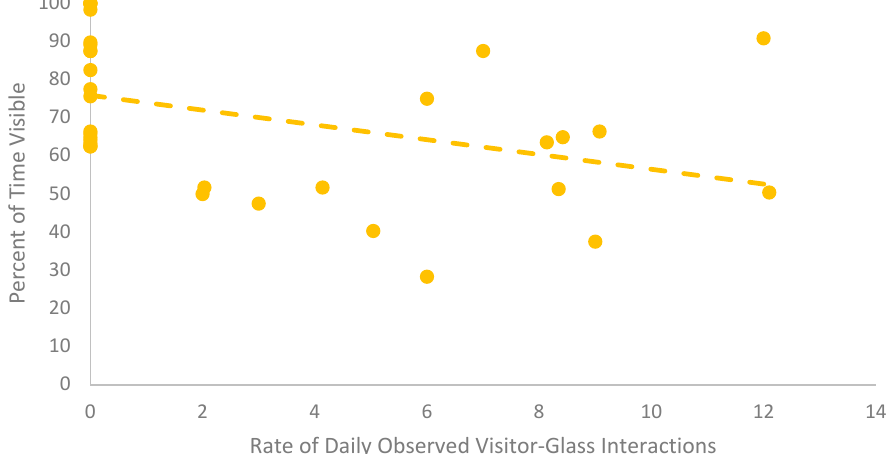
Figure 2. Scatterplot with a trendline comparing the daily rate of visitor-glass interaction and the daily percent of time visible for the group of European glass lizards. Each point represents a single day for the group.